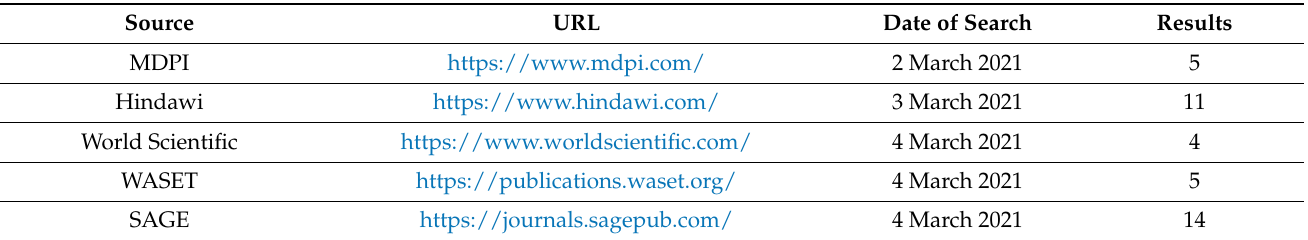
Table 2. Open access publishers used during the review